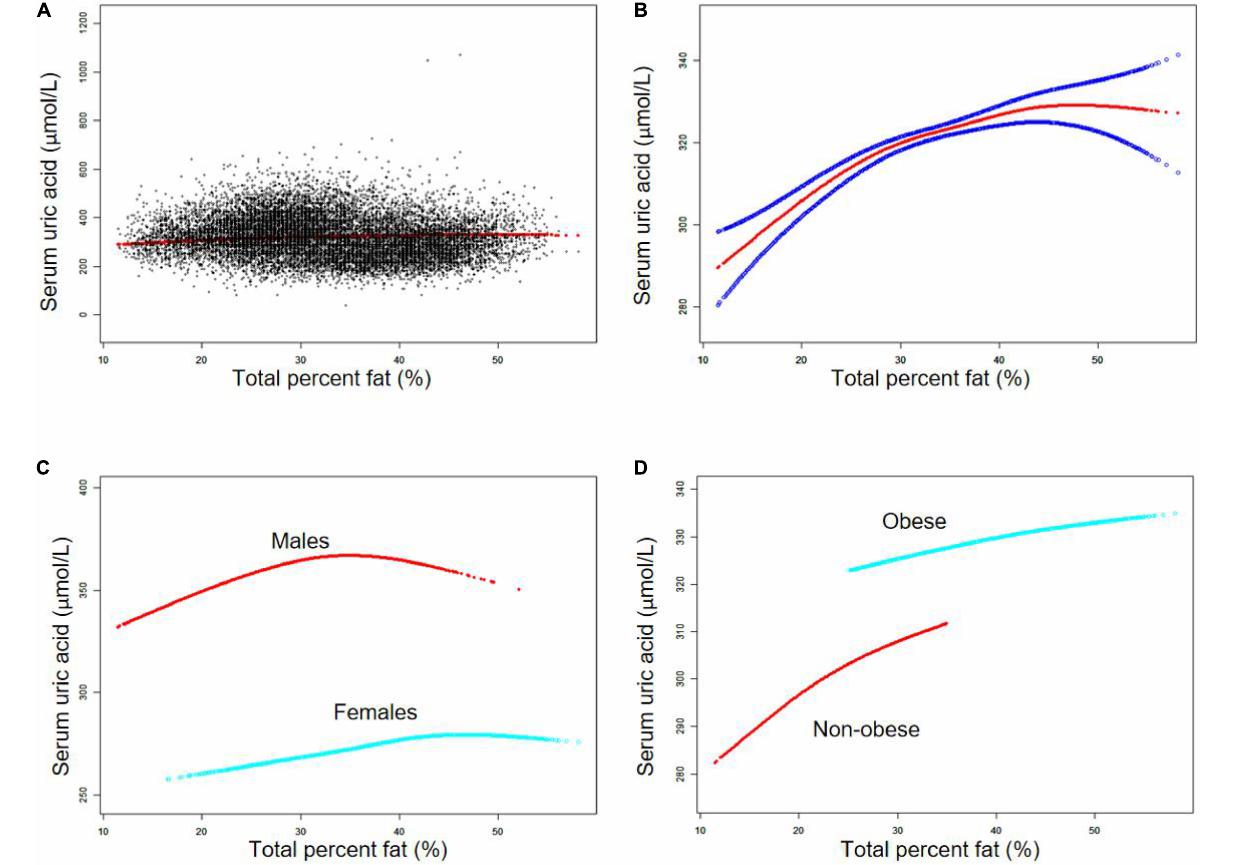
FIGURE 1 | The association between total percent fat (%) and serum uric acid ( µ mol/L). (A) Each black point represents a sample. (B) Solid red line represents the smooth curve fit between variables. Blue bands represent the 95% confidence bands derived from the fit. (C) Stratified by sex. (D) Stratified by obesity status. Age, sex, race, smoking status, heavy alcohol consumption, vigorous work activity, hypertension, diabetes, weak/failing kidneys, body mass index, blood urea nitrogen, cholesterol, triglycerides, education level, ratio of family income to poverty, dietary intakes of energy and nutrients (protein, carbohydrate, and fat), and prescription medication use were adjusted (C was not